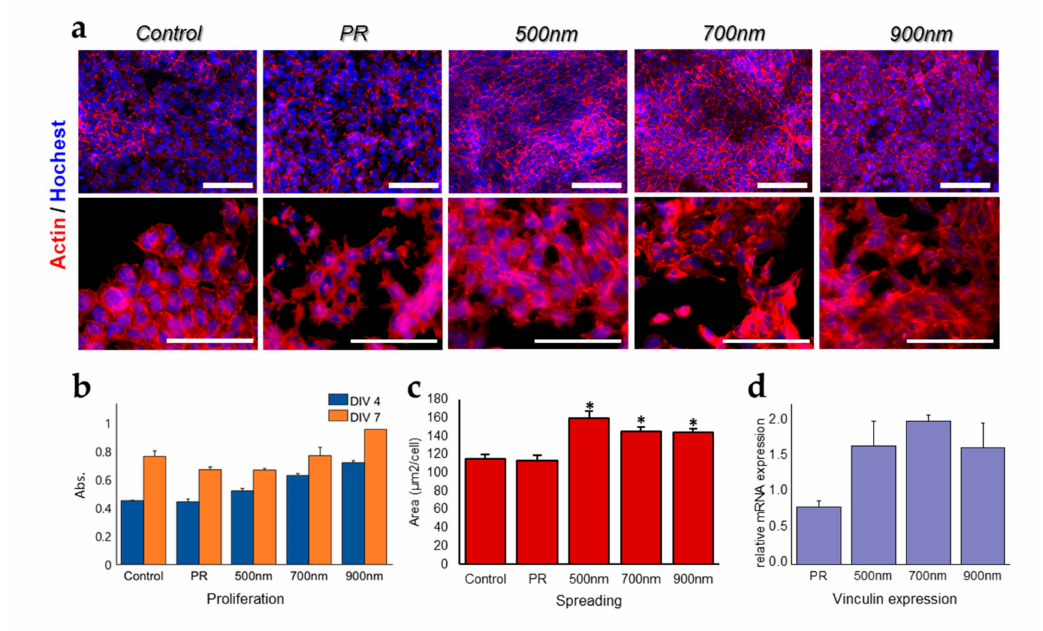
Figure 3. Confirmation of cell adhesion and spreading of mNSCs cultured on all substrates. ( a ) Immunofluorescence staining images of mNSCs with phalloidin, Hoechst, and vinculin after 7 d of proliferation on HNPAs and non-patterned groups (top panel). Enlarged